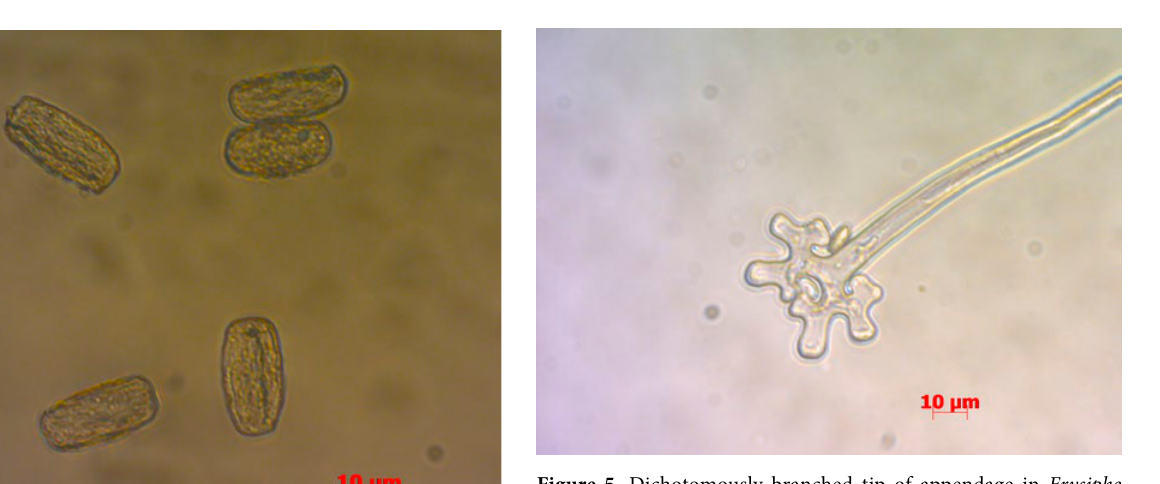
Figure 5. Dichotomously branched tip of appendage in Erysiphe elevata .